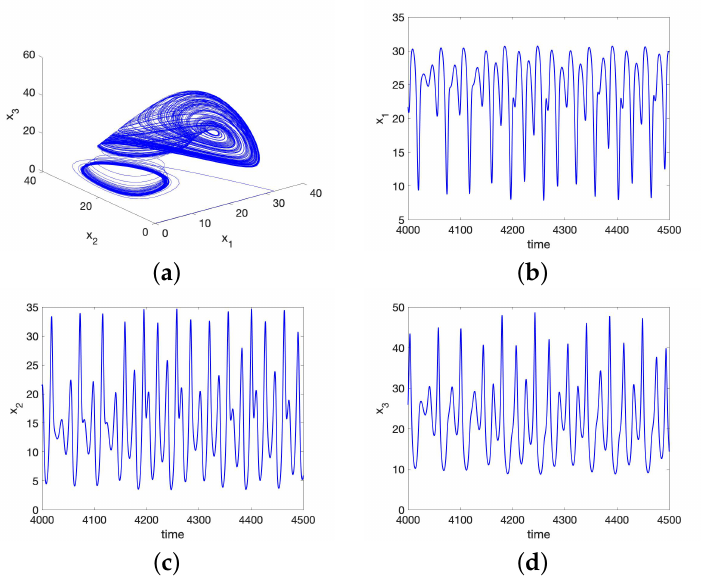
Figure 3. Chaotic dynamics with small initial data [ x 1 ( 0 ) , x 2 ( 0 ) , x 3 ( 0 )] = [ 0.01,0.01,0.1 ] in UR model. ( a ) Phase diagram showing chaotic attractor in UR model. ( b ) Time series plot for x 1 . ( c ) Time series plot for x 2 . ( d ) Time series plot for x 3 .